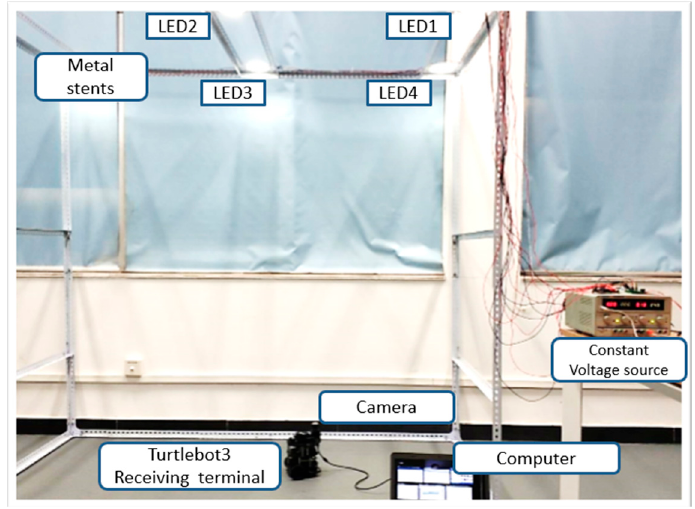
Figure 9. The platform and hardware devices for experimental setup.